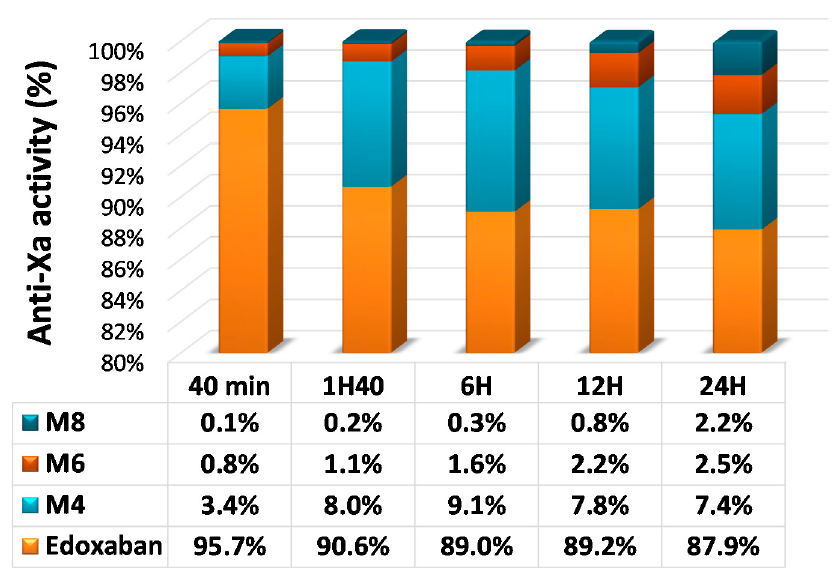
Figure 2. Plasma concentrations of edoxaban and active metabolites after a single oral dose of 60 mg of [ 14 C] edoxaban. Adapted from Bathala et al. [45].